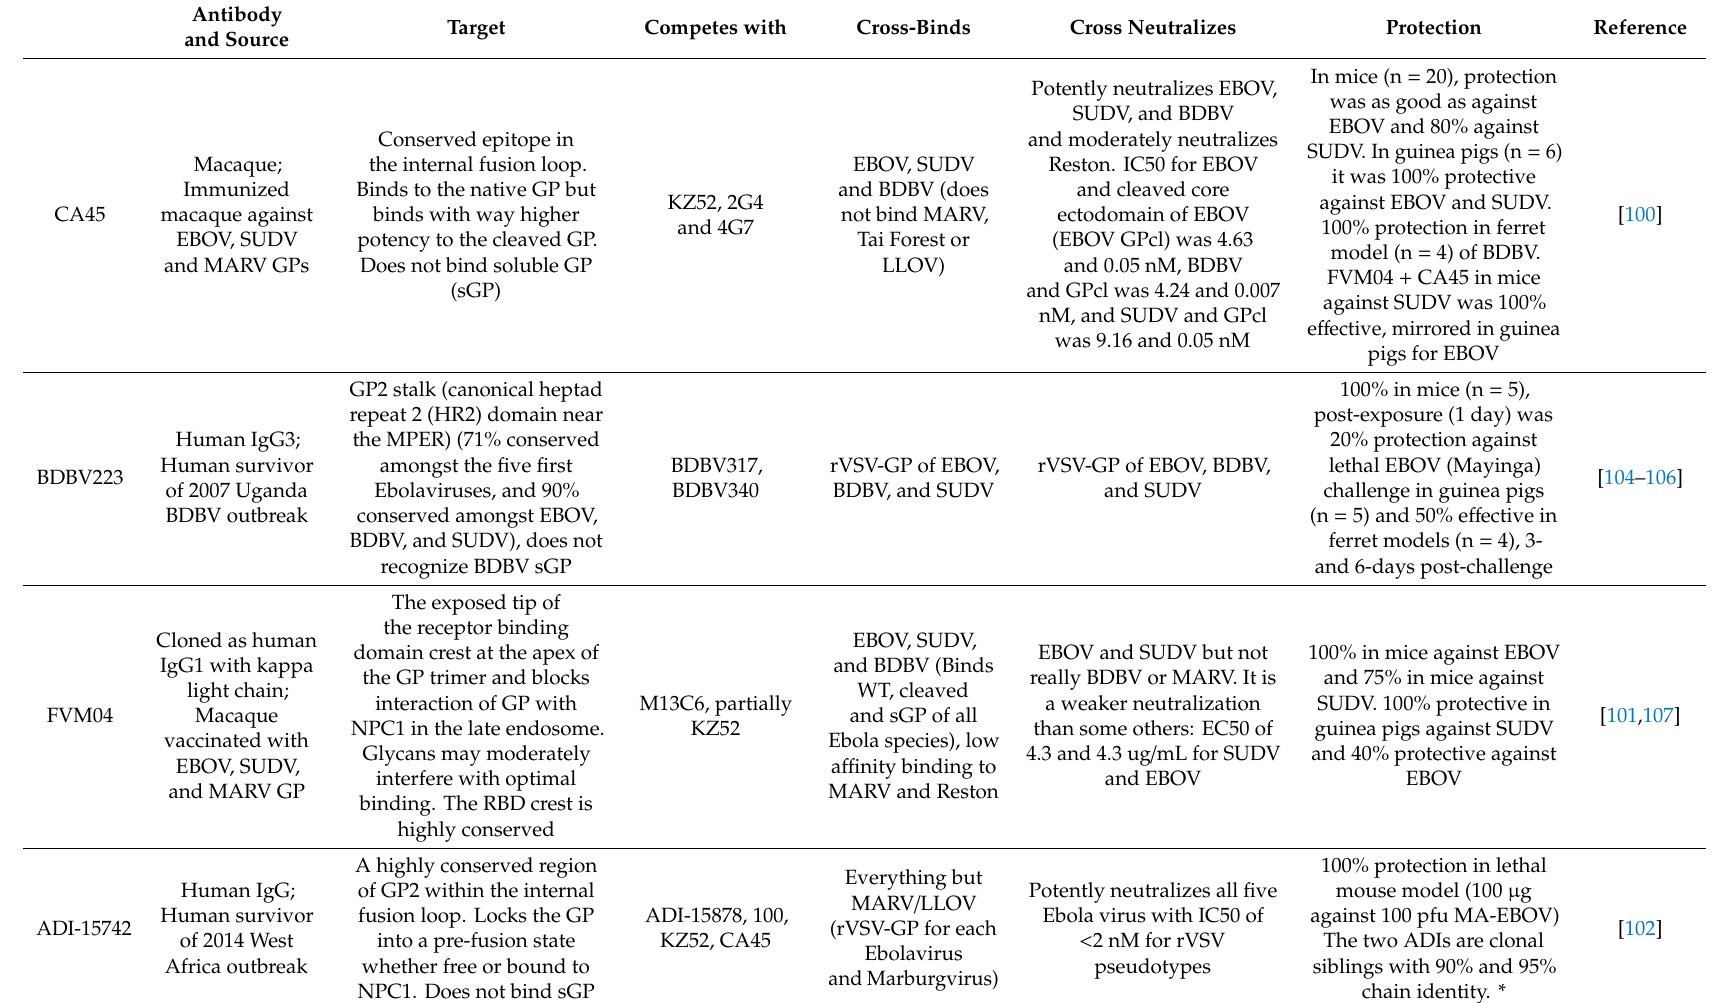
Table 2. Top performing pan-Ebola mAbs from human